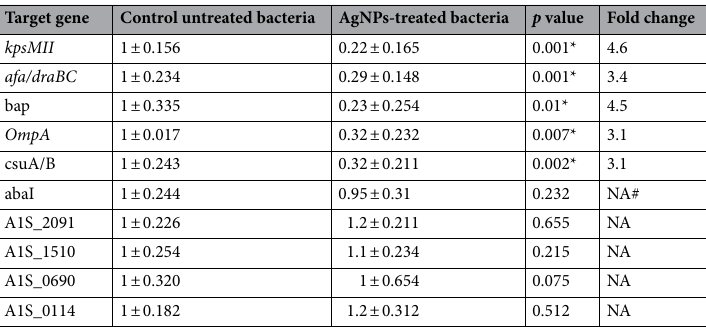
Table 1. Fold change in expression levels of virulence and biofilm-related genes in AgNPs-treated bacteria with respect to the untreated cells. The expression level of each gene was determined with respect to untreated cells, defined as 1. Values represent means ± SD. * p values were calculated by student’s t -test and values < 0.05 indicated significant difference between treated and untreated groups. #; not applicable refers to genes with no statistically significant